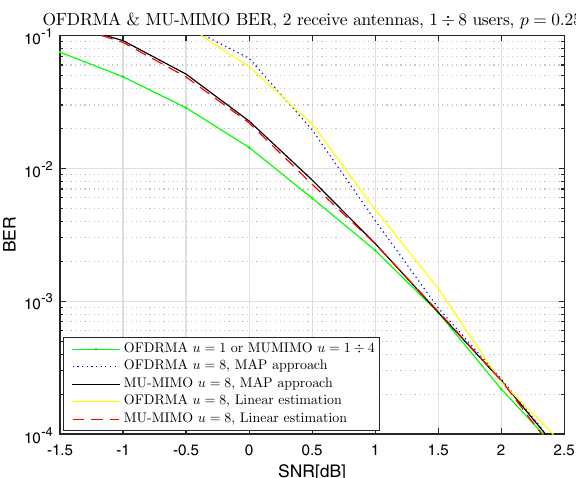
Figure 6. BER vs SNR, OFDRMA & MU-MIMO, QPSK, ϑ = 2 , u = 1 ÷ 8 , p = 0.25